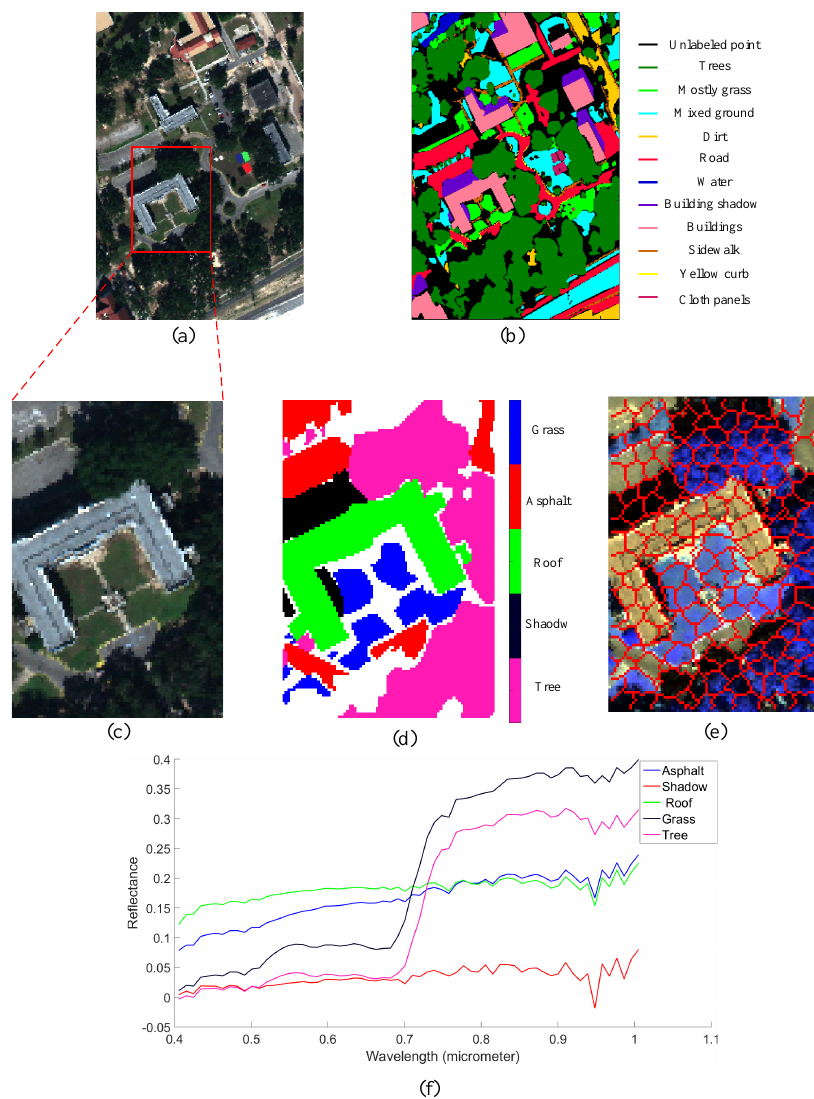
Figure 6. ( a ) The original RGB image. ( b ) The corresponding ground truth materials of Gulfport dataset. ( c ) The selected ROI area. ( d ) The corresponding ground truth materials in the ROI. ( e ) The superpixel map we used for the experiment. ( f ) The wavelength reflectance of mean spectra signature for the 5